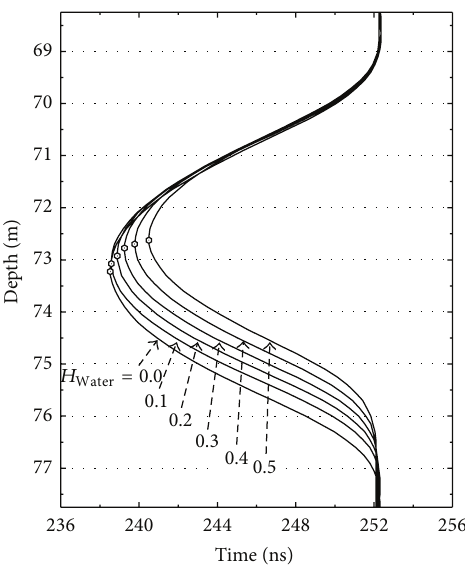
= Figure 6: The time of arrival (TOA) profiles extracted from the B- Water scan images for 6 different height ratios of water inside the tunnel ) with 1% amplitude level of the first positive peak. The fastest ( 𝐻 Water arrival of each TOA profile is marked by a hollo